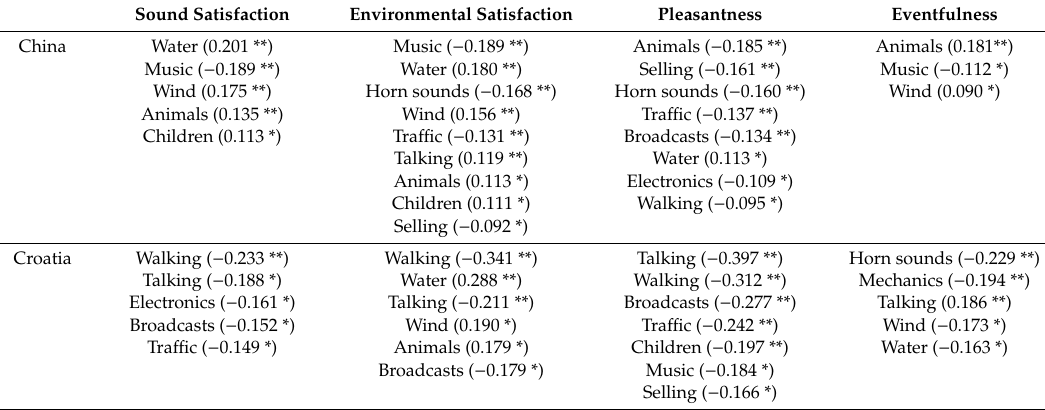
Table 7. Spearman’s rho correlations of each sound source and subjective satisfaction, as well as perceived soundscape factors .